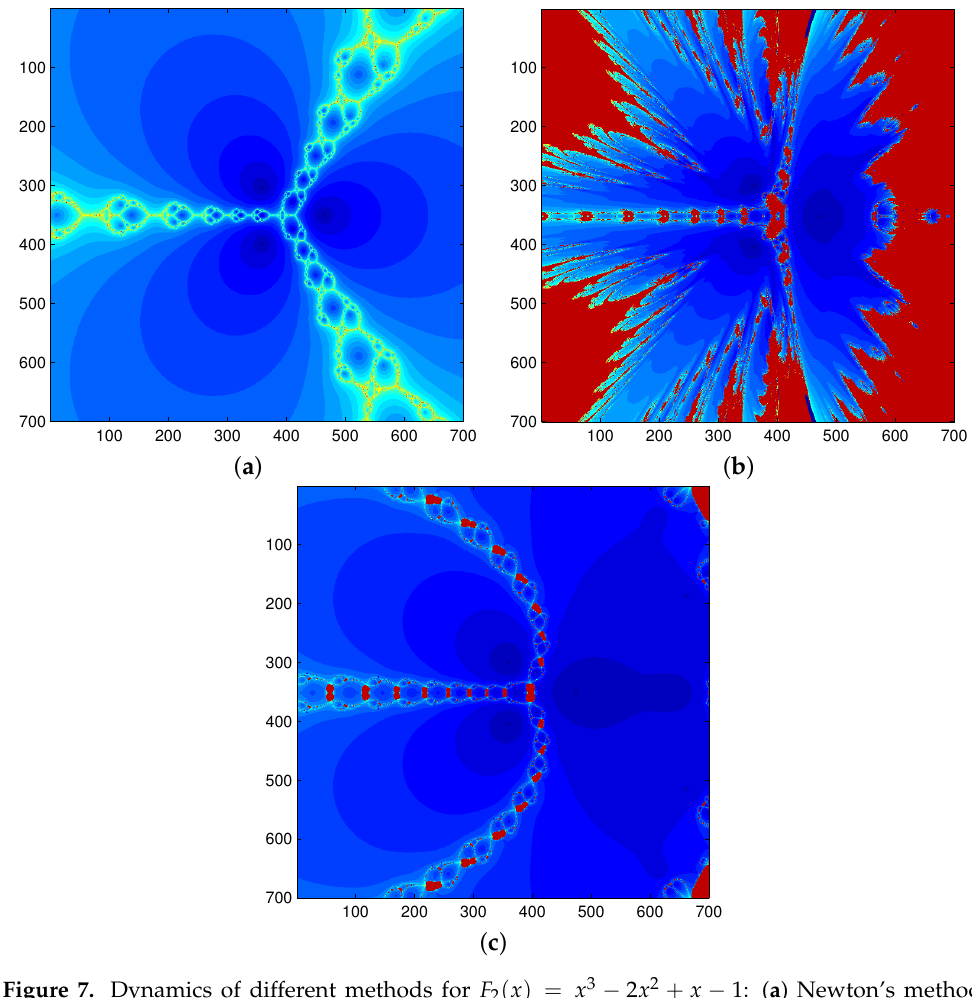
Figure 7. Dynamics of different methods for F 2 ( x ) = x 3 − 2 x 2 + x − 1: ( a ) Newton’s method; ( b ) Wang and Liu’s method; ( c ) proposed